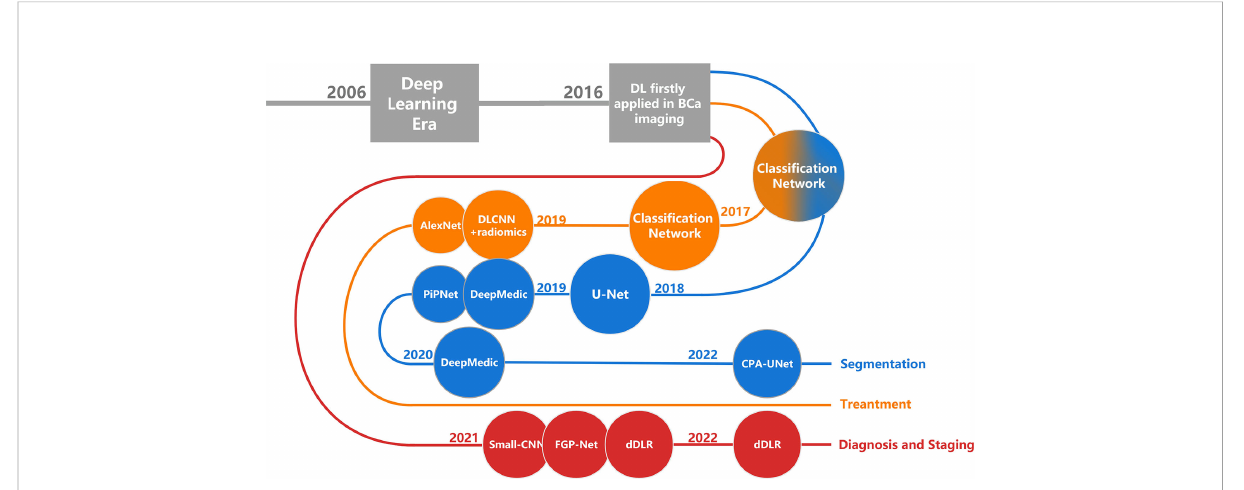
FIGURE 1 The development history of DL in BCa imaging. Each node corresponds to a research, named after the DL architecture that the research primarily used. DL, deep learning; BCa, bladder